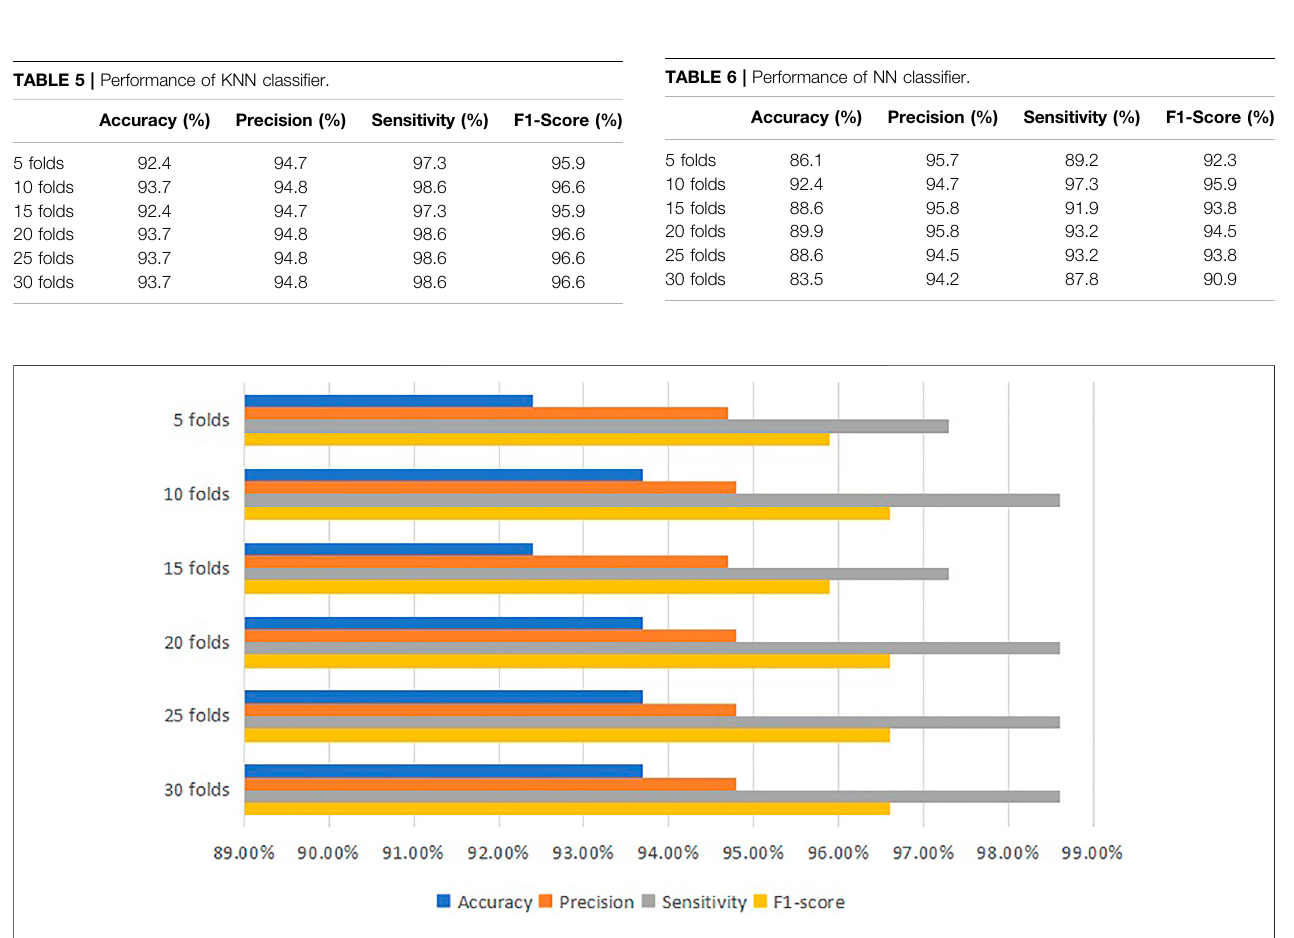
FIGURE 5 | Comparison diagram for the performance of KNN classi fi er.